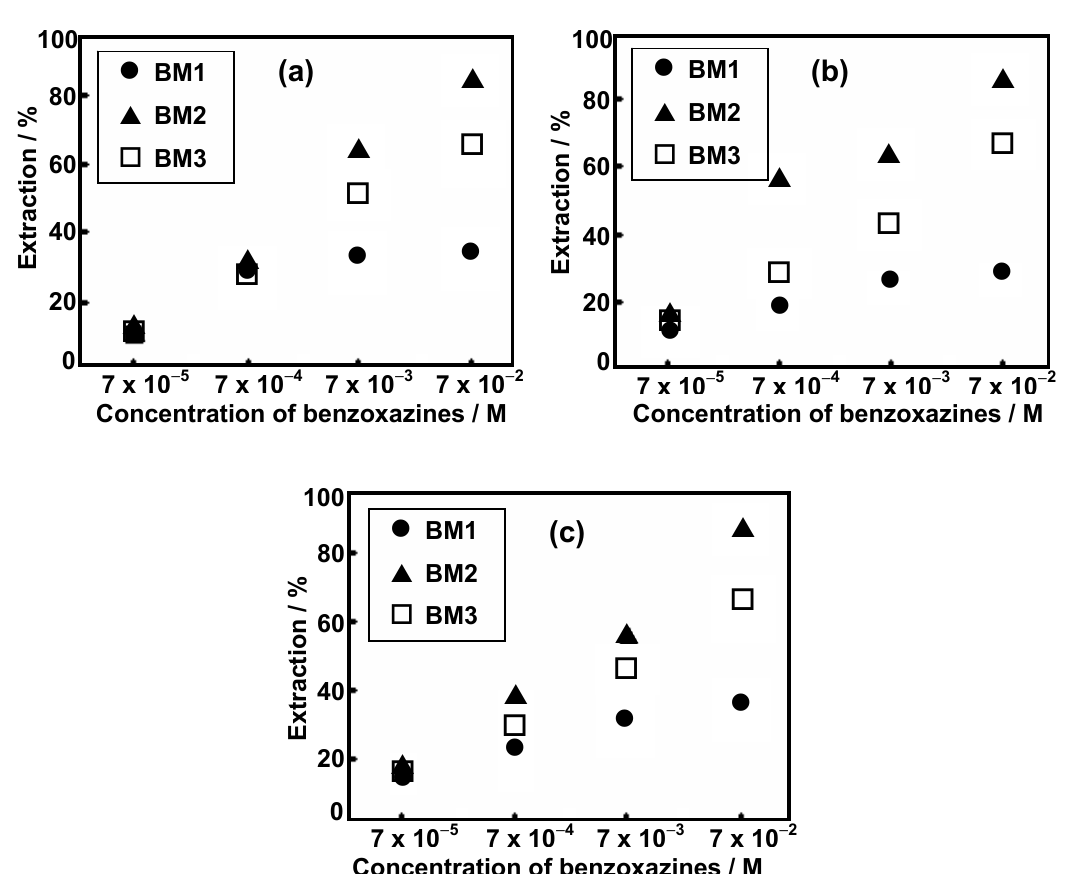
Figure 5. Extraction percentages of 7.0 × 10 − 5 M alkali-picrate ( a ) Na + - picrate, ( b ) K + -picrate, and ( c ) Cs + -picrate by various concentrations of benzoxazine derivatives in CH Cl at 25  2 2